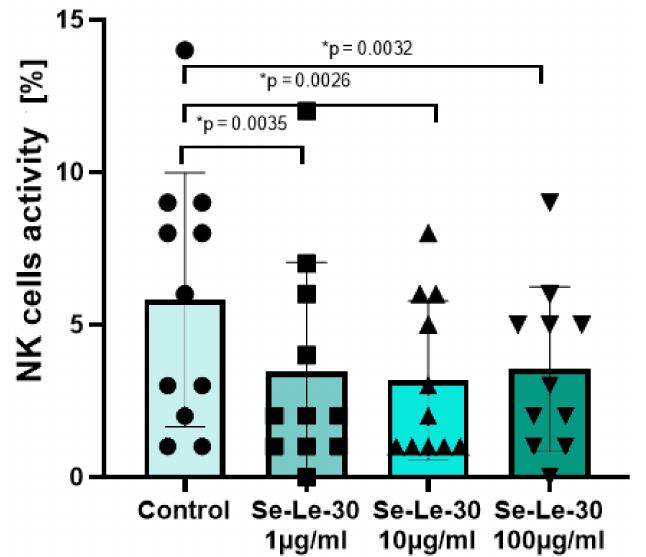
Figure 2. The effect of Se-Le-30 (100 µ g/mL) on peripheral blood mononuclear cells (PBMCs) proliferation in a mixed lymphocyte reaction (MLR). The proliferation of lymphocytes cultured with irradiated PBMCs from the same donor (autostimulation) or from the second unrelated donor (allostimulation) was examined on the DNA synthesis level by the measurement of 3H-thymidine incorporation. The results are presented as a level of radioactivity measured as ‘corrected counts per minute’ (ccpm). Statistical differences were considered when p < 0.05. The mean value ( n = 10) and standard deviation are given. * p < 0.05 vs. control.